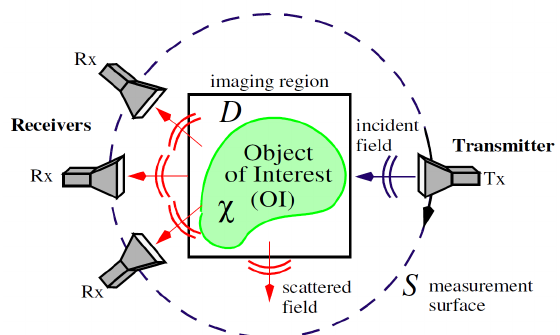
Figure 1. Two-dimensional representation of the imaging problem. The object of interest (OI) has an unknown contrast χ , where D is the imaging domain and S is the surface containing the transmitters (Tx) and receivers